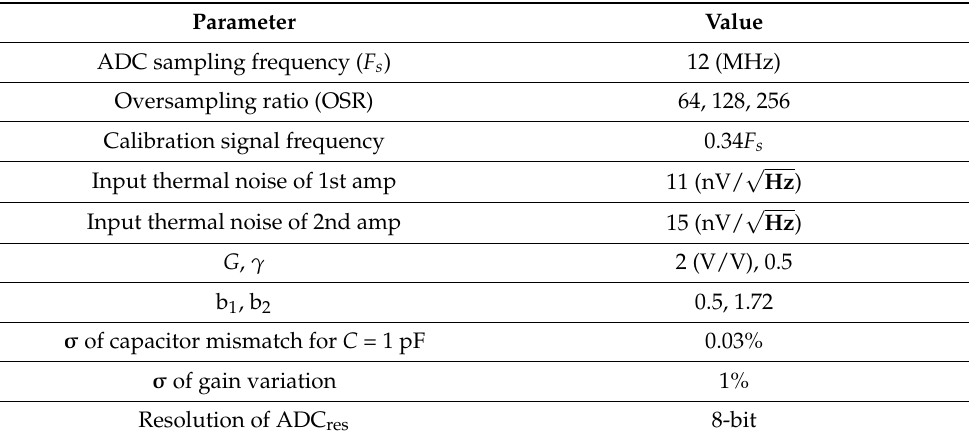
Table 3. ADC parameters for behavioral simulations.